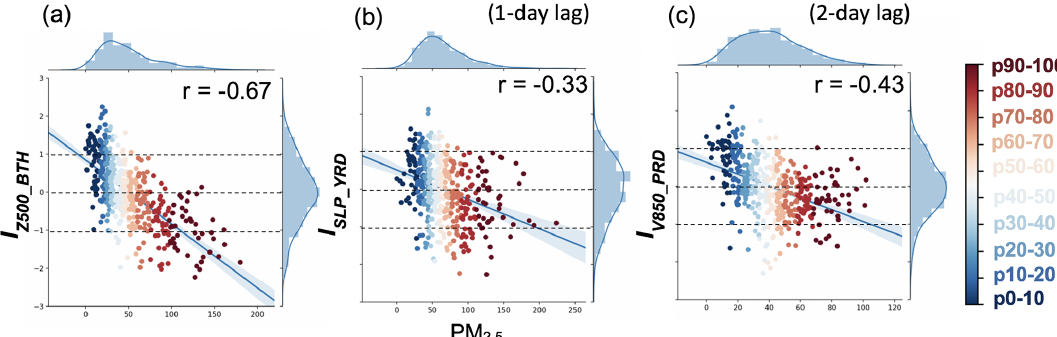
Figure 11. Joint distributions of circulation-based indices against de-trended daily PM 2 . 5 concentrations for different percentile thresholds (colour coded), including the corresponding linear fits with 95% prediction intervals, over (a) BTH, (b) YRD and (c) PRD during DJF 2013–2017. PM 2 . 5 concentrations data are lagged by 1 and 2d behind the circulation indices in the case of YRD and PRD,